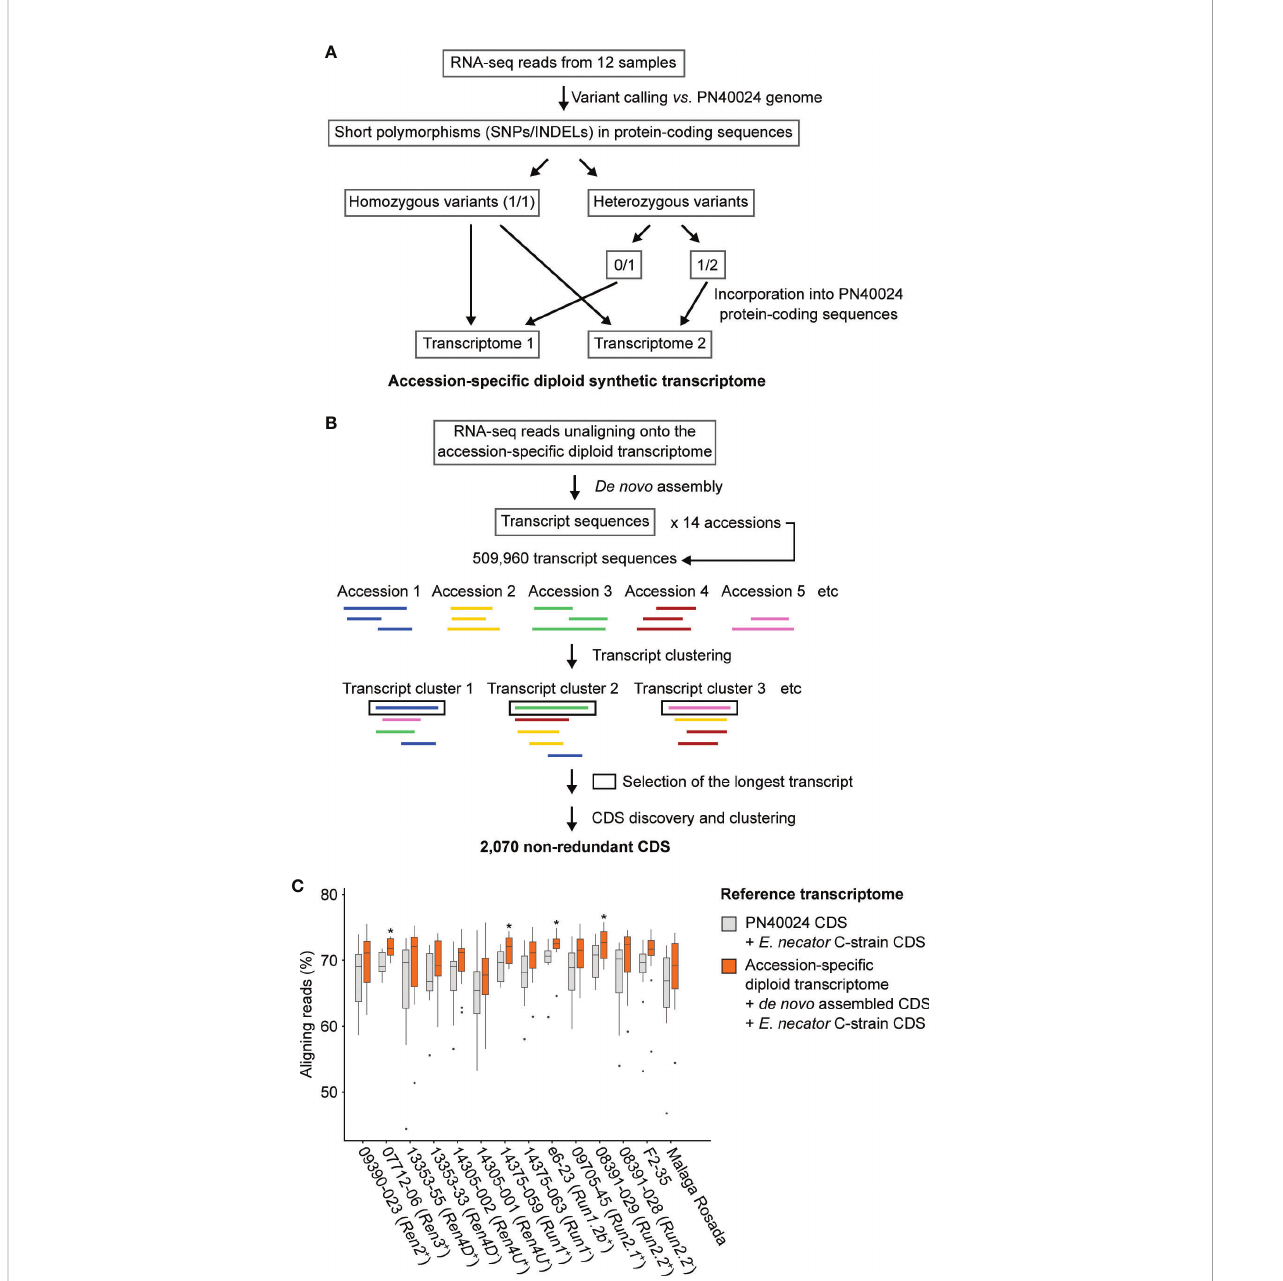
FIGURE 3 Adapting the grape transcriptome to each accession enhances the alignment of RNA-seq reads. Schematic representations of the bioinformatics approaches used to reconstruct the diploid synthetic transcriptome of each grapevine accession (A) and to cluster the de novo assembled transcripts (B) . (C) Effect of the reference transcriptome on the percentage of aligning reads. For each genotype, difference of mapping rate with the combined transcriptomes of PN40024 and E. necator was tested using a Kruskal-Wallis test. * indicates P value ≤